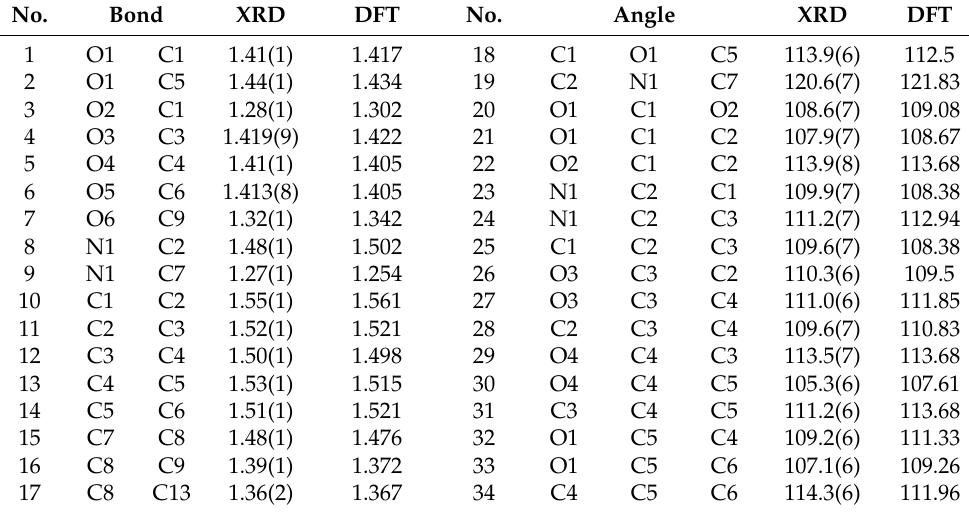
Table 2. Elected X-ray diffraction (XRD)/DFT angles ( o ) and bond lengths (Å).